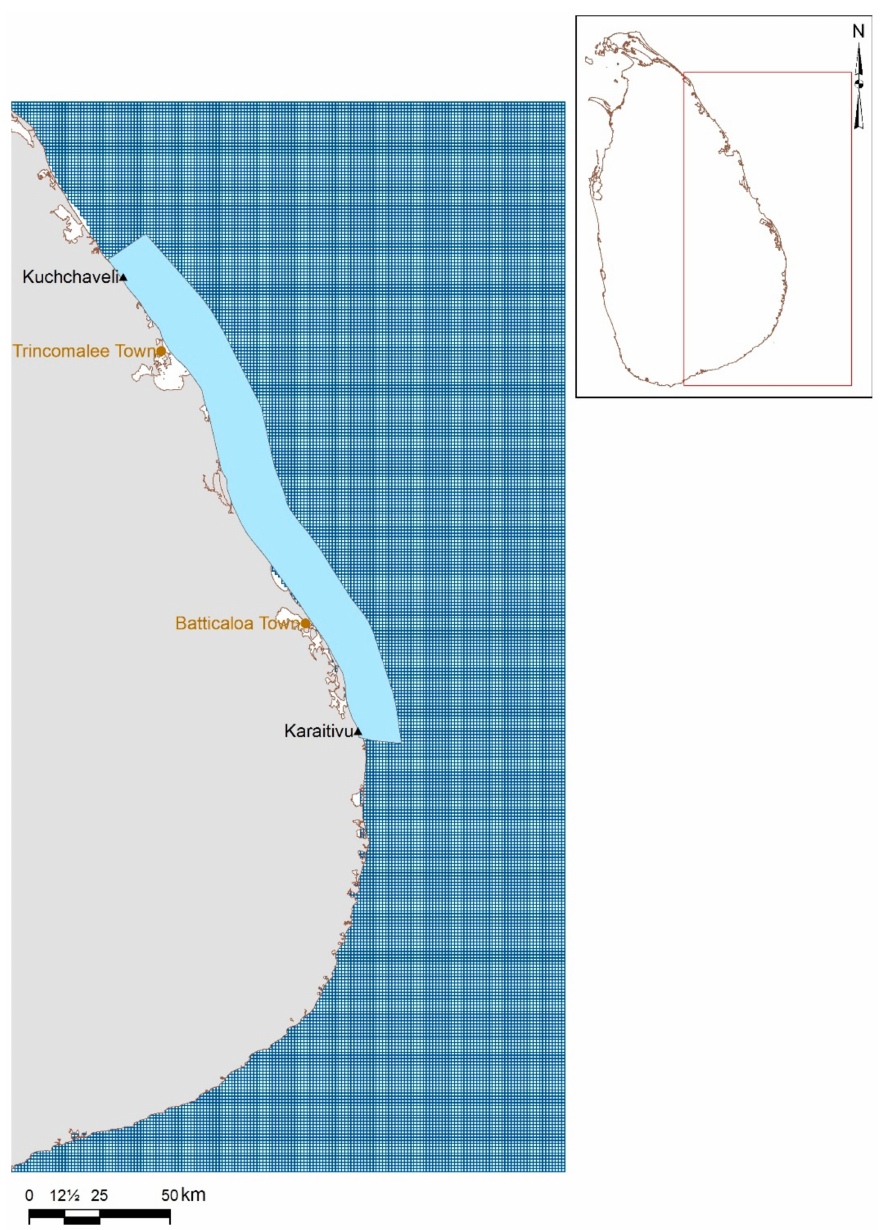
Figure 4. Regional and local wave model grids for the wave